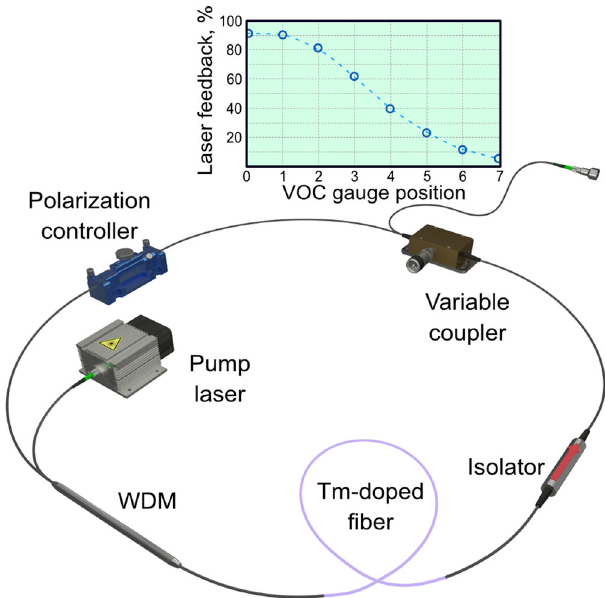
Fig. 2 Schematic of the ultrafast Thulium-doped fi bre laser. The oscillator comprises a single-mode pump laser (Er-doped fi bre laser at 1.55 μ m), a wavelength division multiplexer (WDM), Tm-doped fi bre, a polarisation- insensitive isolator, an in-line variable output coupler (VOC) and a squeezing type polarisation controller. All passive fi bres are polarisation- insensitive SMF28e. Note, the VOC is replaced by a fi xed, fused coupler with 20% feedback for the section “ Pulse duration and laser optimisation ” . The inset depicts the nonlinear course of the coupling coef fi cient against the VOC's